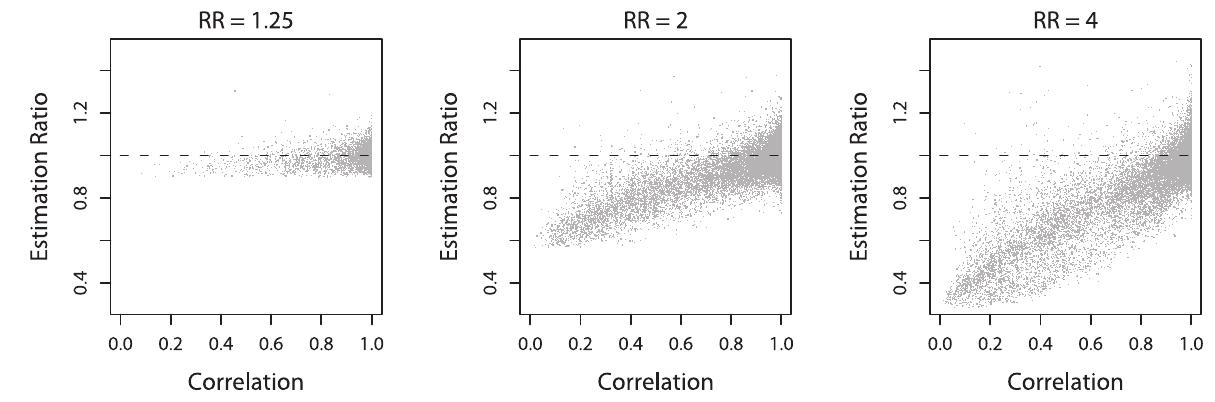
Figure 2. Relationship between underestimation and correlation. Scatter plots of the ratio of estimated to true relative risk against the correlation (r 2 ) between the disease SNP and the hit SNP, for three different true relative risks. The horizontal dashed line indicates a ratio of 1. Points below the line are under-estimated, and above are over-estimated. (Note that in the case where the hit SNP is also the causal SNP the correlation is 1.)